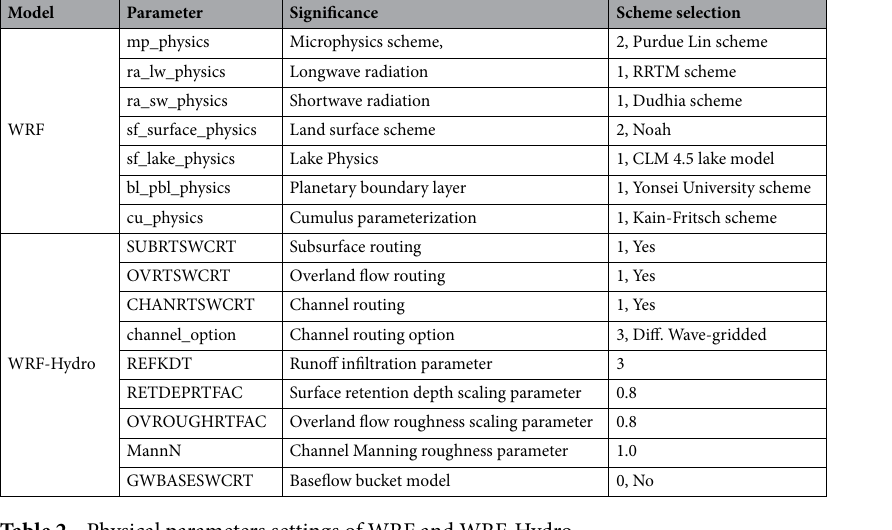
Table 2. Physical parameters settings of WRF and